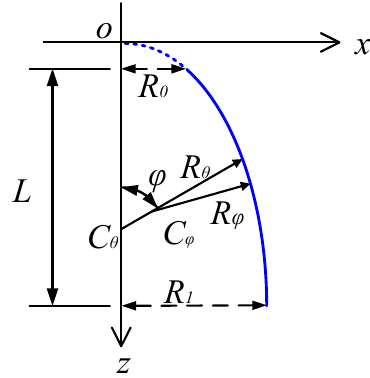
Figure 2. The geometric of doubly curved paraboloidal shell.